Question: Author a descriptive caption for the visualization shown.
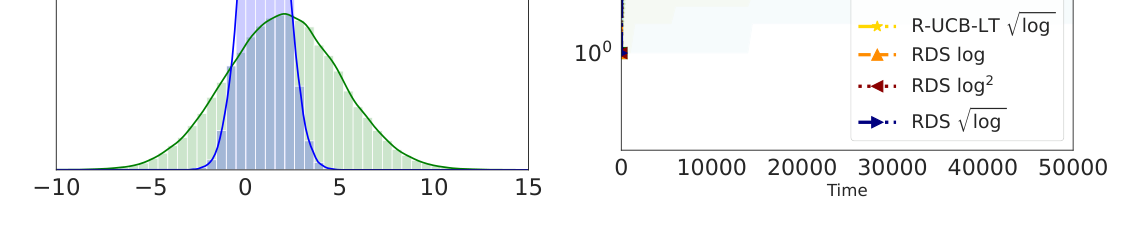
Answer: 4 – Comparison of DS algorithms against benchmarks on a seven-armed DSSAT bandit, with parameters ρ = 4 (BDS), ρ = 4, α = 5% (QDS) and ρn = p